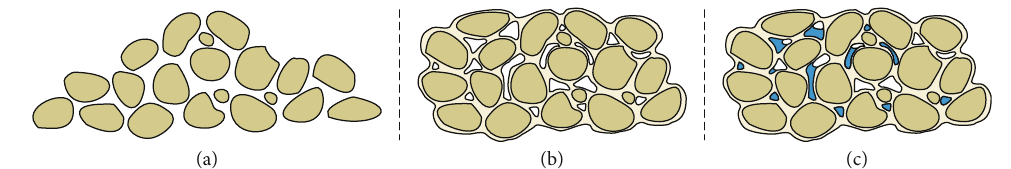
Figure 15: The interaction between sand particles, PU membrane, and water: (a) dry sand; (b) sand mixed with PU; (c) PU-sand mixture immersed in water.